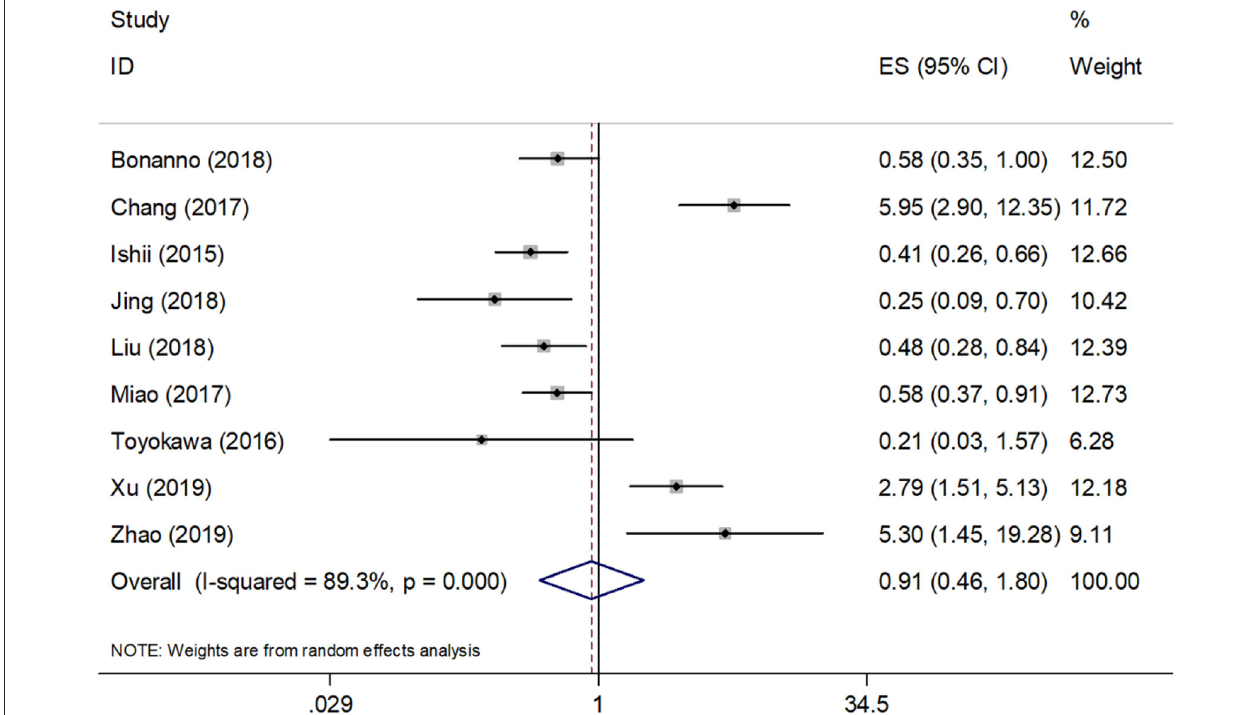
FIGURE 2 | Meta-analysis of the association between PD-L1 expression and OS.